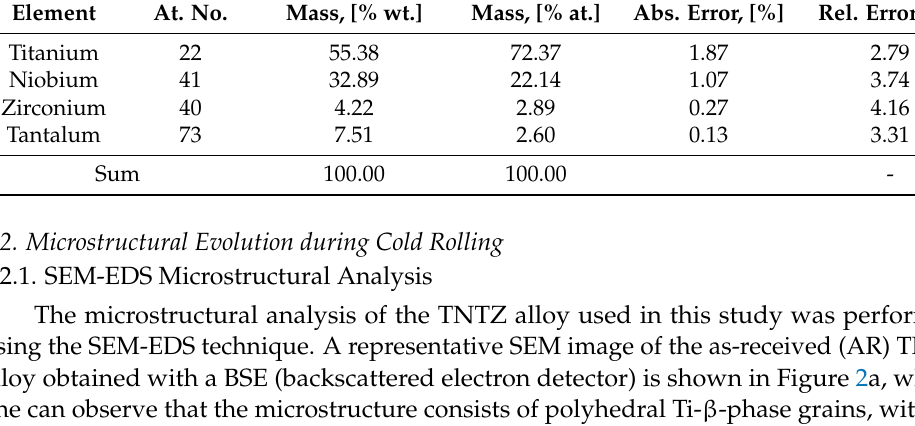
Table 1. The quantitative chemical composition of the as-received (AR) TNZT alloy. Element At. No. Mass, [% wt.] Mass, [% at.] Abs. Error, [%] Rel. Error, [%] Titanium 22 55.38 72.37 Niobium 41